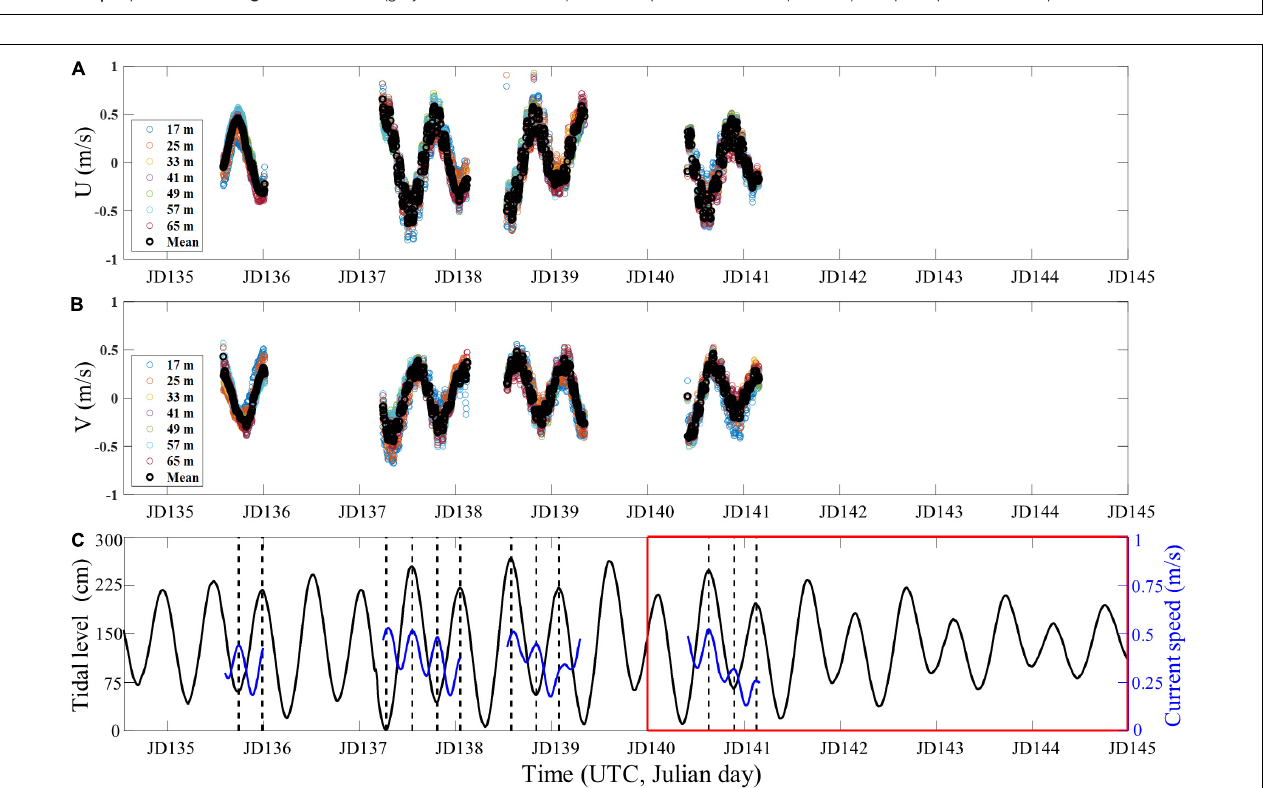
FIGURE 9 | Time series of (A) zonal and (B) meridional components of the current velocity measured at various depths and their respective mean values (thick black circles). (C) The mean current speed (blue line) computed from panels (A,B) is superimposed on the tide (black line) at VLA1 site throughout the experiment (JD 135–JD 145). The vertical dashed lines denote the times of high and low tides. Our snap rate was estimated during the period in the red box (JD 140–JD 145).